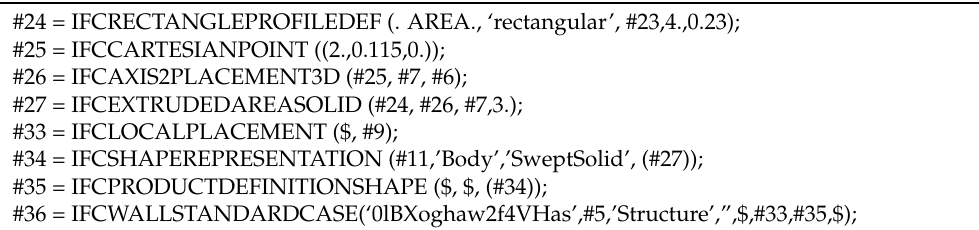
Table 1. Entities of a Wall and its Hierarchy